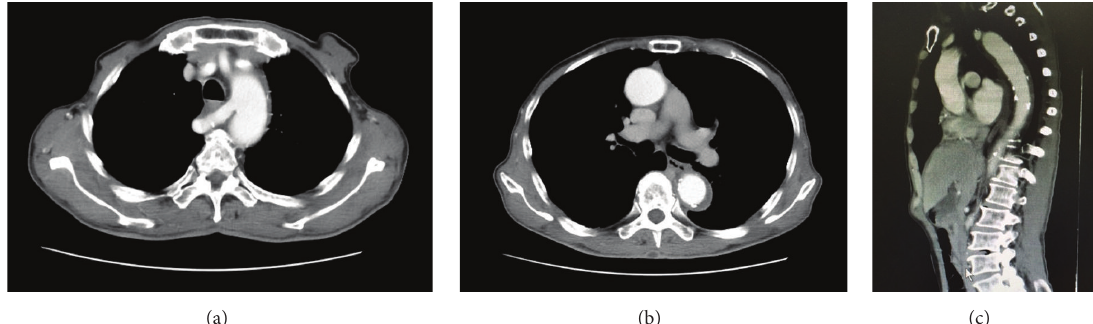
Figure 1: Contrast-enhanced CT images at time of onset. (a, b) Horizontal cross section. The origin of the right subclavian artery is identified as the fourth branch of the aortic arch and runs posteriorly to the right of the esophagus. No dissection of the right subclavian artery was present. Thrombosis of the false lumen from the origin to periphery of the right subclavian artery was observed. (c) Sagittal section. False lumen was observed. Total false lumen thrombosis was observed, and no signs of ULP were noted.